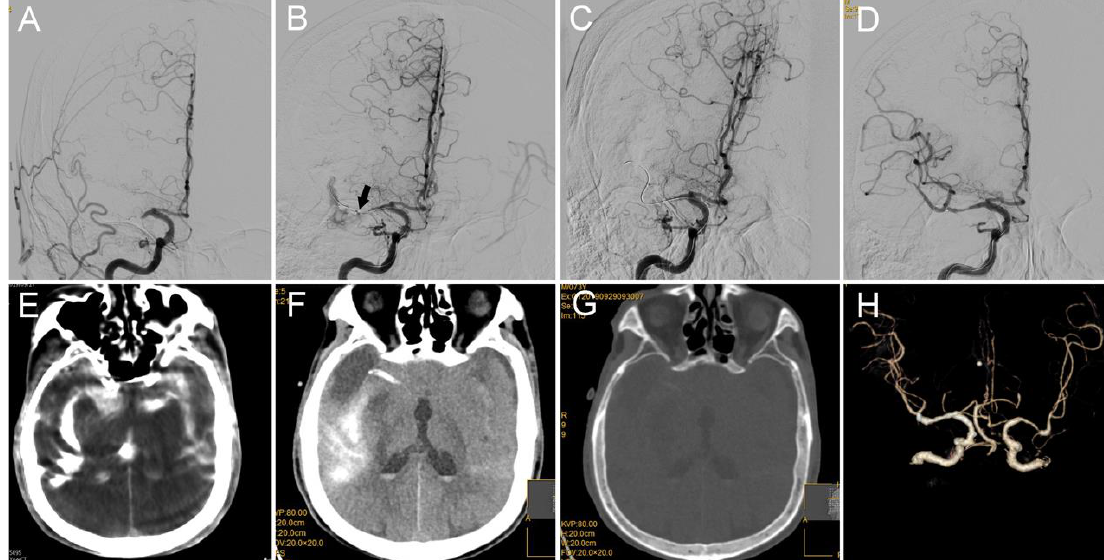
Figure 2. ( A ) DSA shows occlusion of the M1 segment of the right MCA. ( B ) A microcatheter is advanced into the M1/2 branch (the arrow indicates the tip of the microcatheter), where active contrast extravasation pointing to the location of vessel perforation can be observed (indicated with arrow). ( C ) After the injection of 400 U thrombin via the microcatheter and no following contrast extravasation, the contrast extravasation is stopped. ( D ) mTICI 3 reperfusion was achieved after the detachment of the stent retriever and administration of intravenous tirofiban. ( E ) Severe hyperdensity within the Sylvian fissure and ventricle was observed on C-arm CT performed during the procedure. ( F , G ) The hyperdense area was dismissed on follow-up CT and disappeared on dual-energy CT, which indicates that it was a contrast agent but not a blood product. ( H ) Patency of the culprit artery was observed on the follow-up CTA. MCA: middle cerebral artery; mTICI: modified thrombolysis in cerebral infarction; CTA: computed tomography angiography.